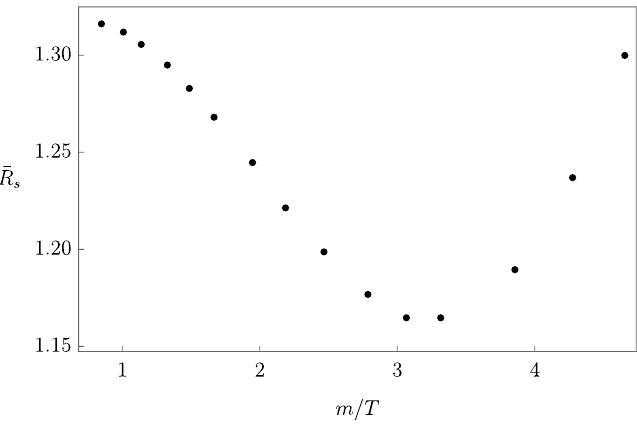
Figure 14 . Dimensionless radius of convergence ¯ R s plotted as a function of the symmetry breaking parameter m/T for holographic solids (with spontaneously broken translations) with the potential V ( X ) = X 3